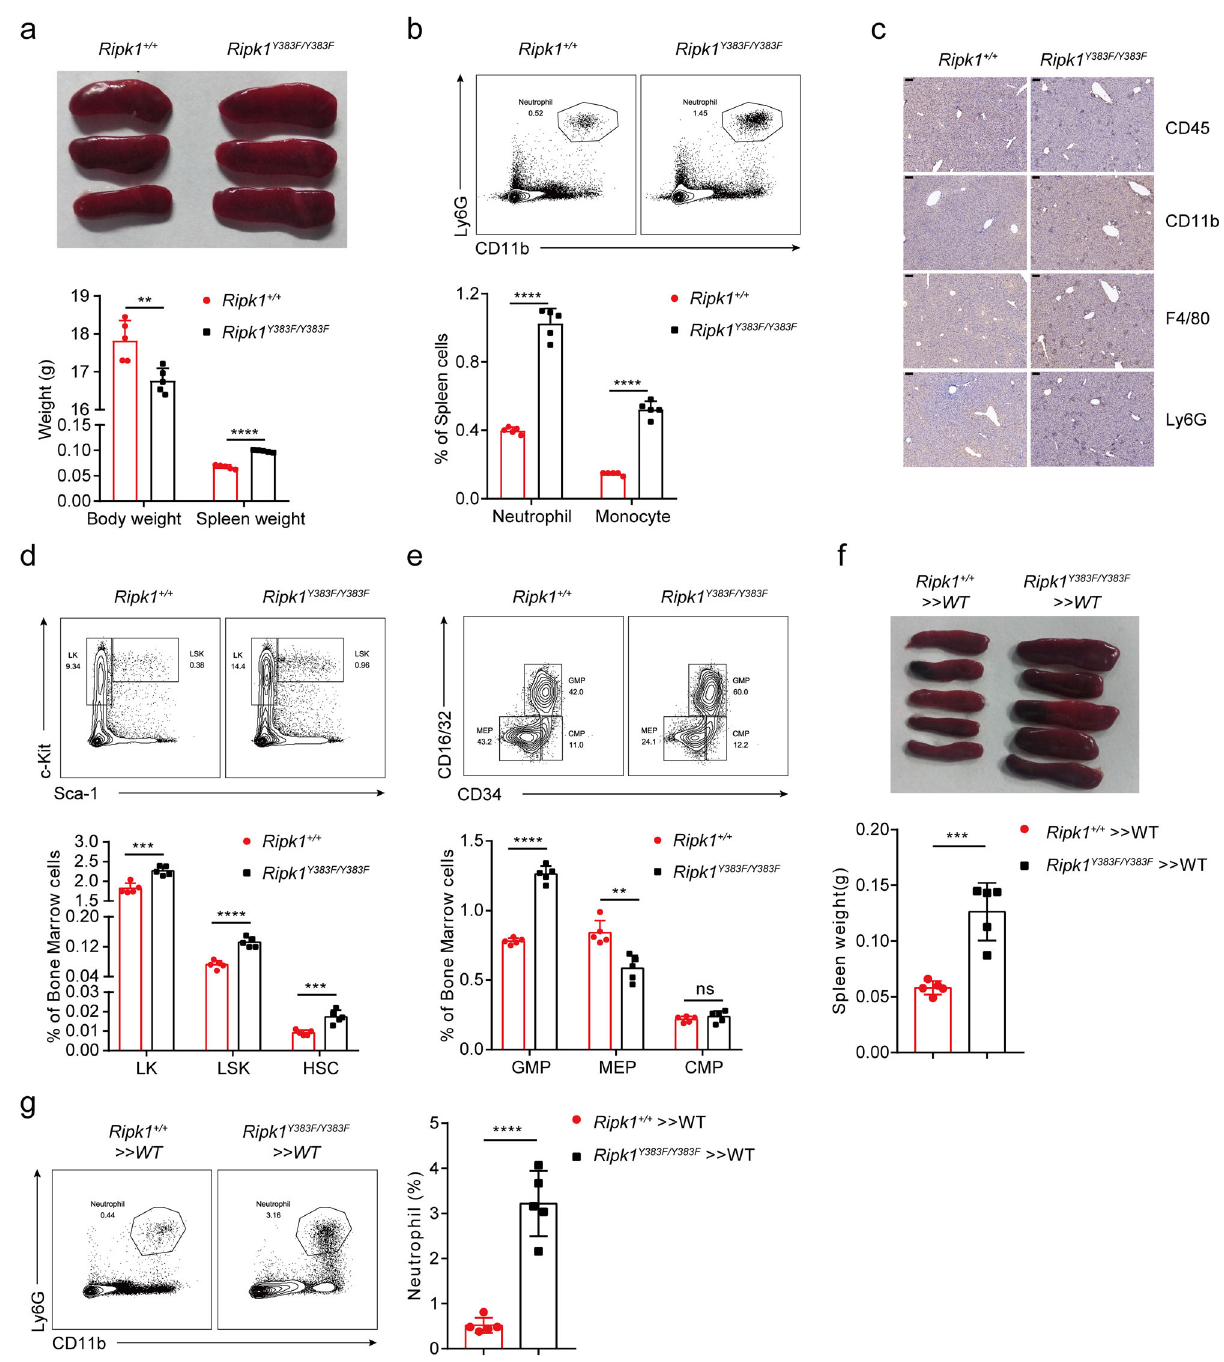
Fig. 5 | RIPK1 Y383F mice develop systemic in fl ammation and emergency hematopoiesis. a Representative images of spleen tissue and statistical results of spleen weight from Ripk1 +/+ ( n =5) and Ripk1 Y383F/Y383F ( n =5) female mice at age of 6 weeks. b Flow cytometry and statistical analysis of neutrophils (CD11b + Ly6G + )andmonocytes(CD11b + Ly6C + )inthespleenof Ripk1 +/+ ( n =5)and Ripk1 Y383F/Y383F ( n =5) mice at 8 weeks of age. c Immunohistochemical staining of CD11b, Ly6G, CD45 or F4/80 in liver sections of Ripk1 +/+ and Ripk1 Y383F/Y383F lit- termate mice at age of 8 weeks (Scale bar, 100 μ m). Flow cytometry and sta- tistical analysis in bone marrow for the indicated hematopoietic populations: